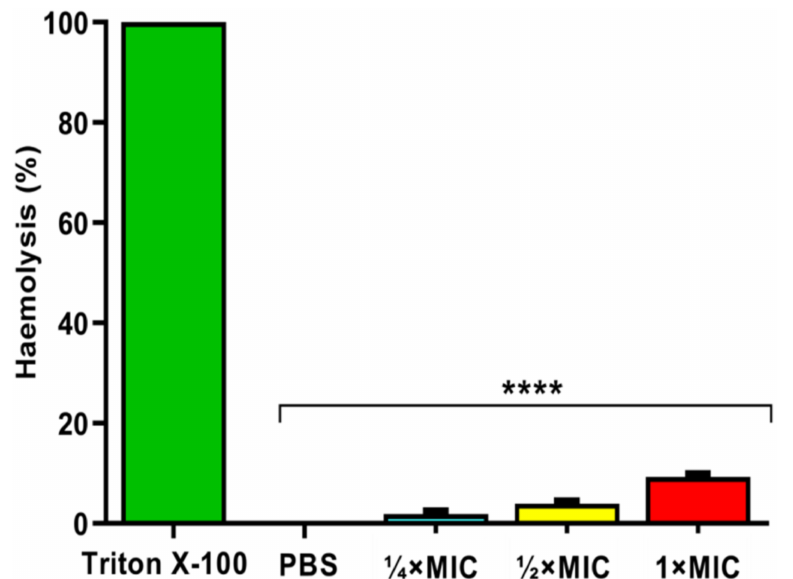
Figure 17. Haemolytic activity of Ag-Cu bimetallic NP at different concentrations. Haemolysis was determined by an absorbance reading at 450 nm and compared to haemolysis achieved with 1% Triton X-100 (reference for 100% haemolysis). PBS and 1% Triton X-100 served as negative and positive controls, respectively. **** p value <